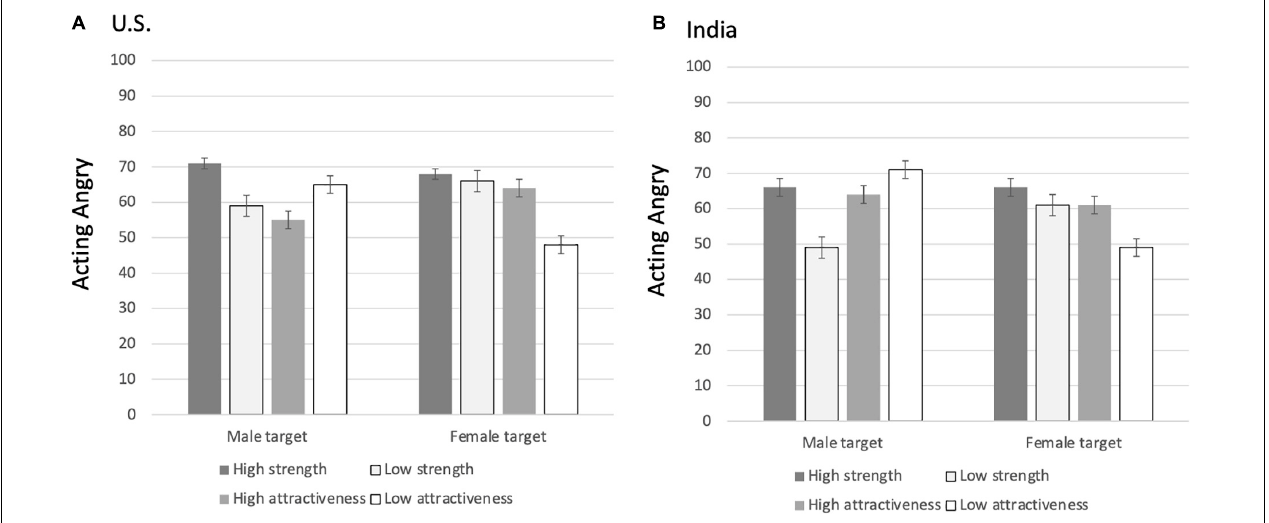
FIGURE 1 | United States participants’ (A) and Indian participants’ (B) expectations of anger enacted by male and female targets.